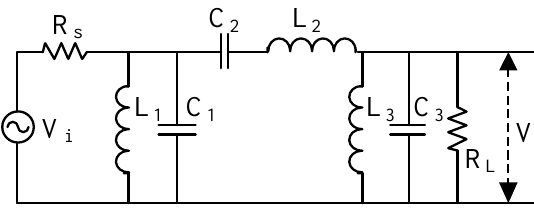
Figure 5. π type 3 order LC passive bandpass filter.